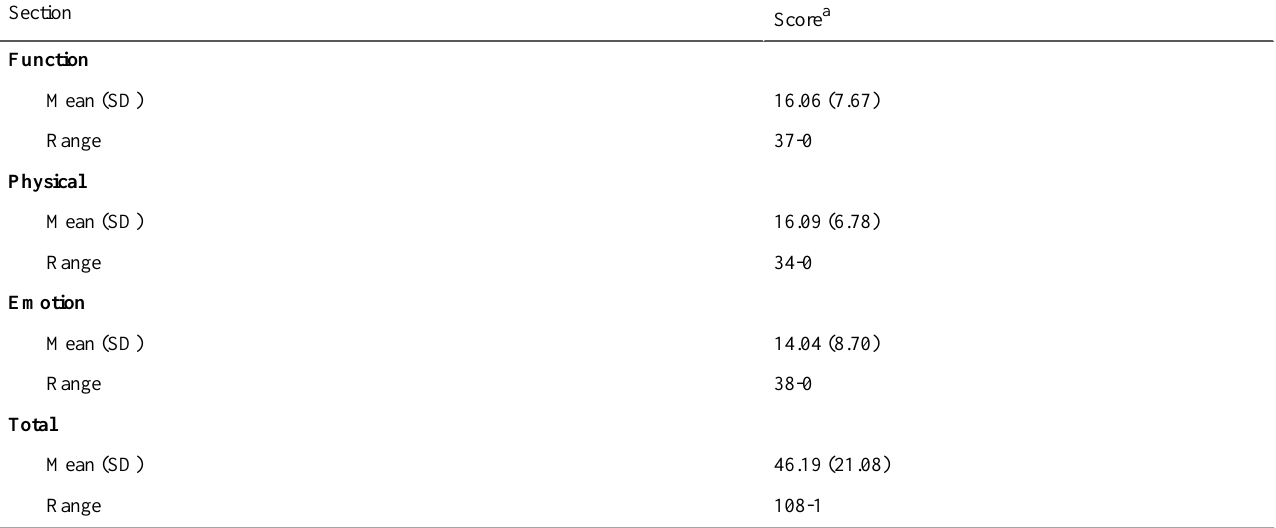
Table 1. Voice Handicap Index scores by